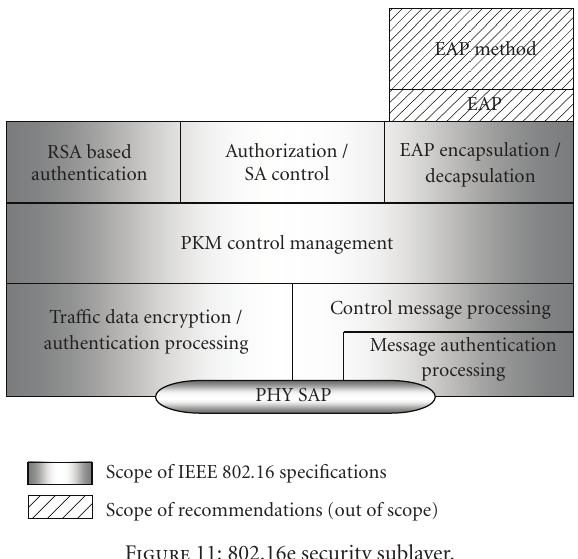
Figure 11: 802.16e security